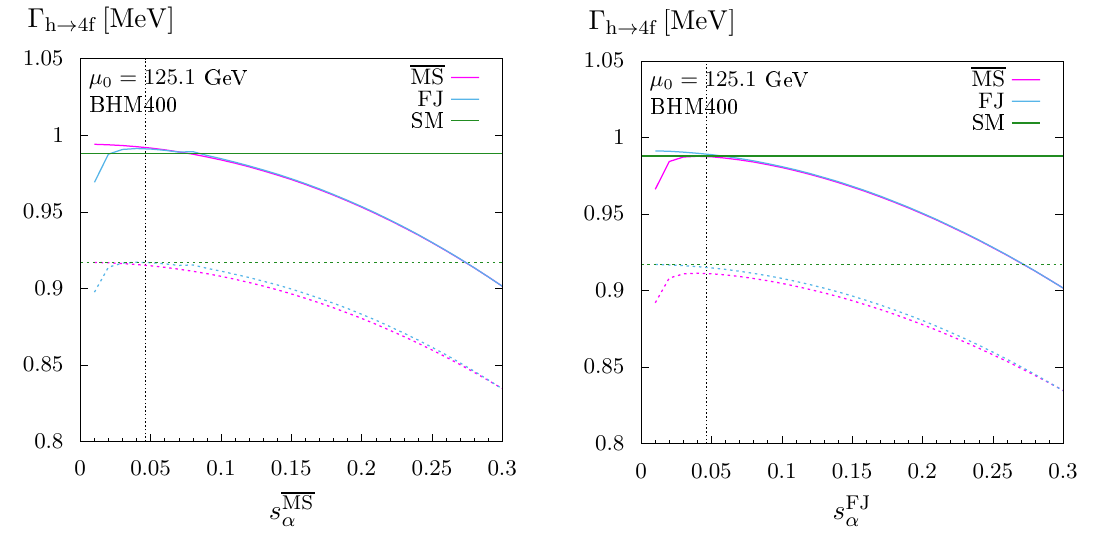
Figure 33 . As in (cid:12)gure 12, but for benchmark scenario BHM400.